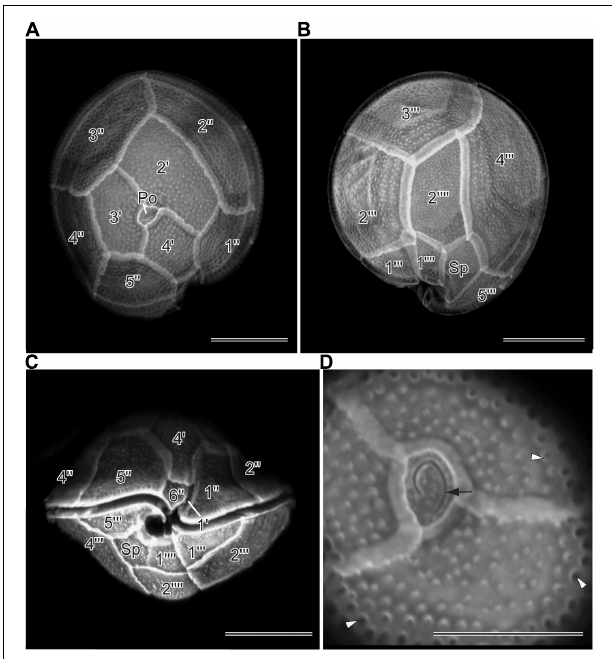
FIGURE 2 | Confocal Laser Scanning Microscopy of calcofluor stained Gambierdiscus balechii (Gtox112513) (A) apical view (B) antapical view (C) ventral view (D) . apical view. Apical pore plate showing the fishhook-shaped slit (black arrow) and pores (white arrow head). Scale = 20 µ m (A–C) , 10 µ m (D) . Apical pore plate (Po), apical plates (1 (cid:48) –4 (cid:48) ), precingular plates (1 (cid:48)(cid:48) –6 (cid:48)(cid:48) ), postcingular plates (1 (cid:48)(cid:48)(cid:48) –5 (cid:48)(cid:48)(cid:48) ), and antapical plates (1 (cid:48)(cid:48)(cid:48)(cid:48) and 2 (cid:48)(cid:48)(cid:48)(cid:48)